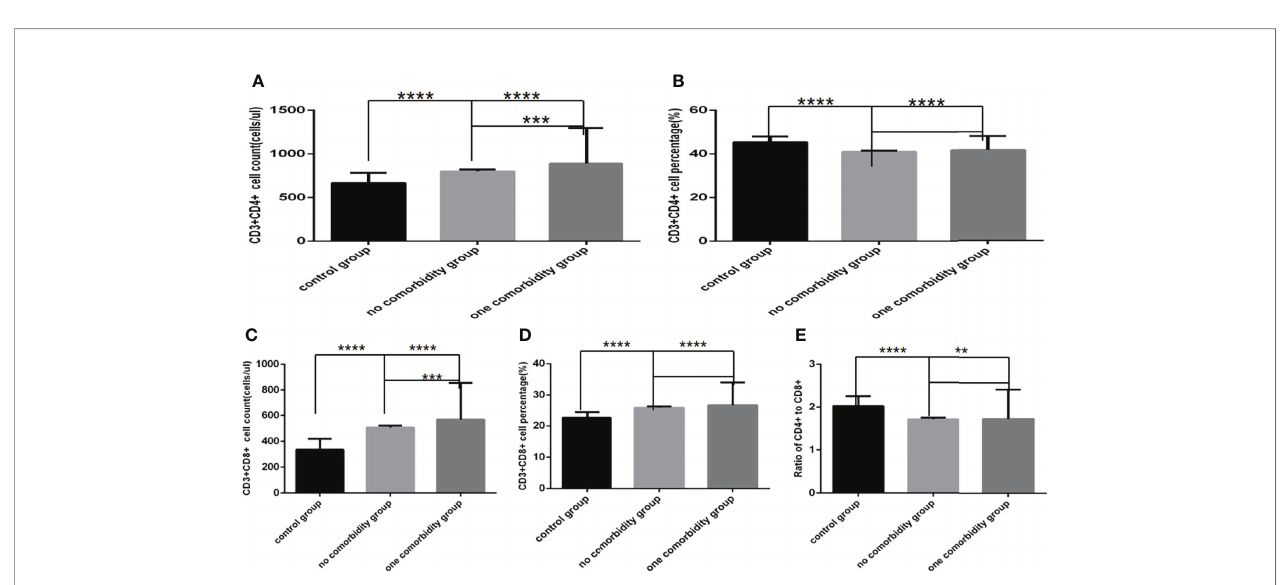
FIGURE 5 | Comparison of T cell subset counts and percentages the control group, the no comorbidity group and the one comorbidity group ( n =494; control, no, one comorbidity groups, n =55, 246 and 193 cases, respectively). COVID-19, coronavirus disease 2019. NAFLD, nonalcoholic fatty liver disease. DM, diabetes mellitus. CHB, chronic hepatitis (B) COPD, chronic obstructive pulmonary disease. CKD, chronic kidney disease. CVD, cardiovascular disease. (A) CD3+CD4+ cell count. (B) CD3+CD4+ cell percentage. (C) CD3+CD8+ cell count. (D) CD3+CD8+ cell percentage. (E) Ratio of CD4+/CD8+ cells. Unpaired one-way ANOVA was used for intergroup comparisons ( A, B, C, D, E , P all<0.0001). Unpaired t -tests were used for comparisons with the control group, and with the no comorbidity group, ** P < 0.01, *** P < 0.001, **** P <